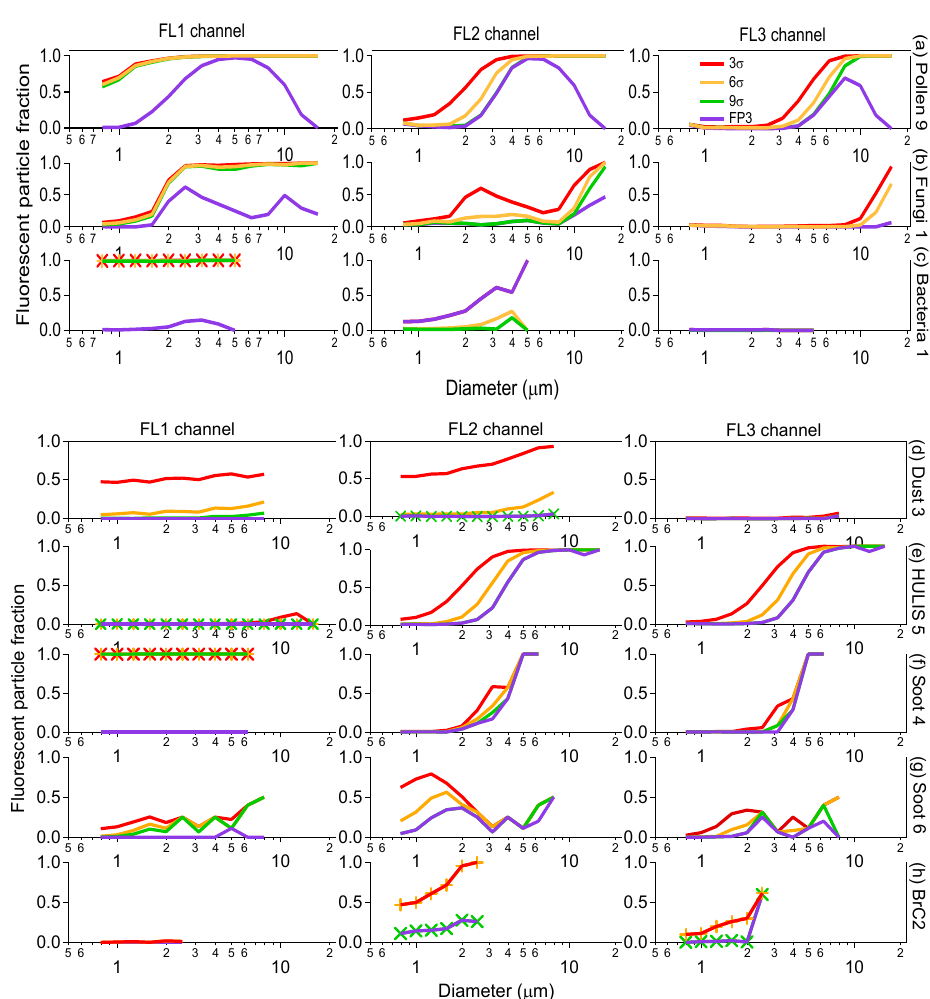
Figure 6. Fraction of particle number exhibiting fluorescent in a given channel versus particle diameter for various material types for four different thresholds definitions. Data markers shown only when disambiguation of traces is necessary. Brown carbon sample denoted by